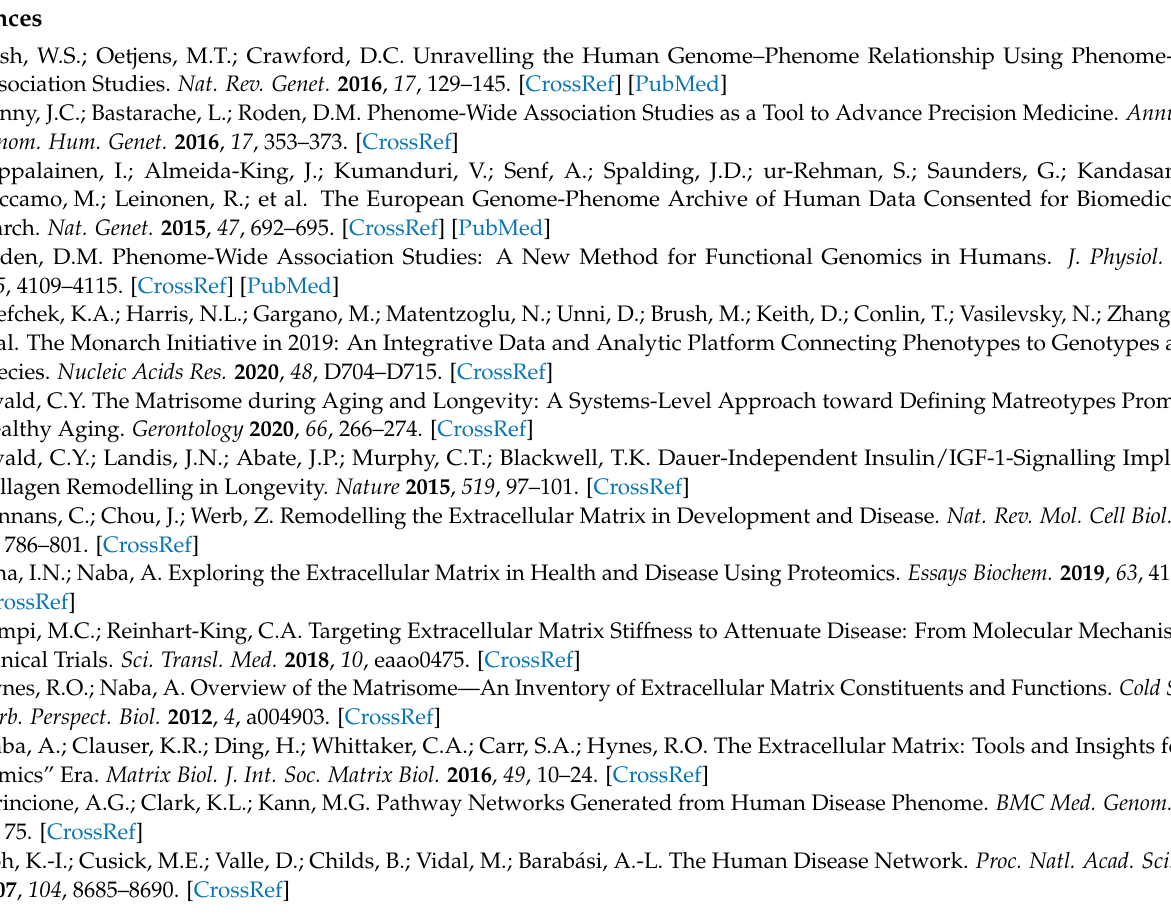
Disease Associations. Table S1: PheWAS of GWAS Catalog of SNVs. Table S2: Matrisome-Protein- Complex Data. Table S3: Matrsiome–Matrisome-Interaction Data. Table S4: Human-Disease Data. Table S5: Clinical-Variant Matrisome Data. Table S6: Monarch Disease Data. Table S7: UK Biobank Top 1000 Data; Table S8: ECM Diseasome. Table S9: SNP and Matrisome Diseasome. Table S10: ECM- Based Drug Repurposing. Table S11: Matrisome and Rare